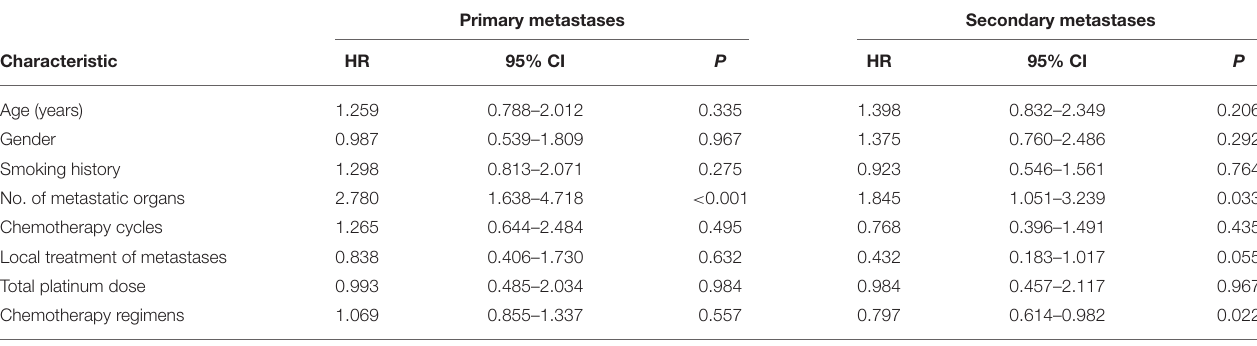
TABLE 4 | Multivariable analyses in primary metastatic and secondary metastatic patients.